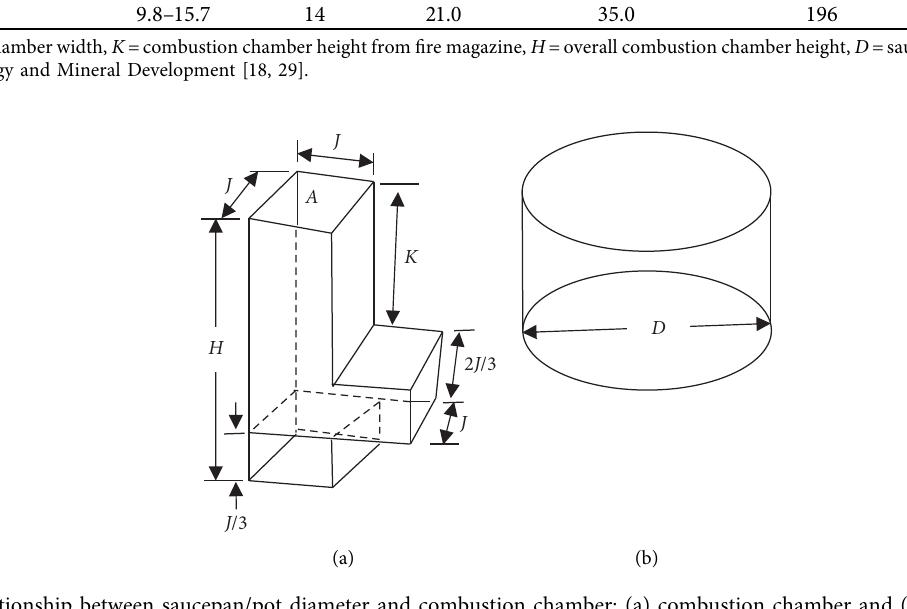
Figure 1: Relationship between saucepan/pot diameter and combustion chamber: (a) combustion chamber and (b) saucepan [18, 29].